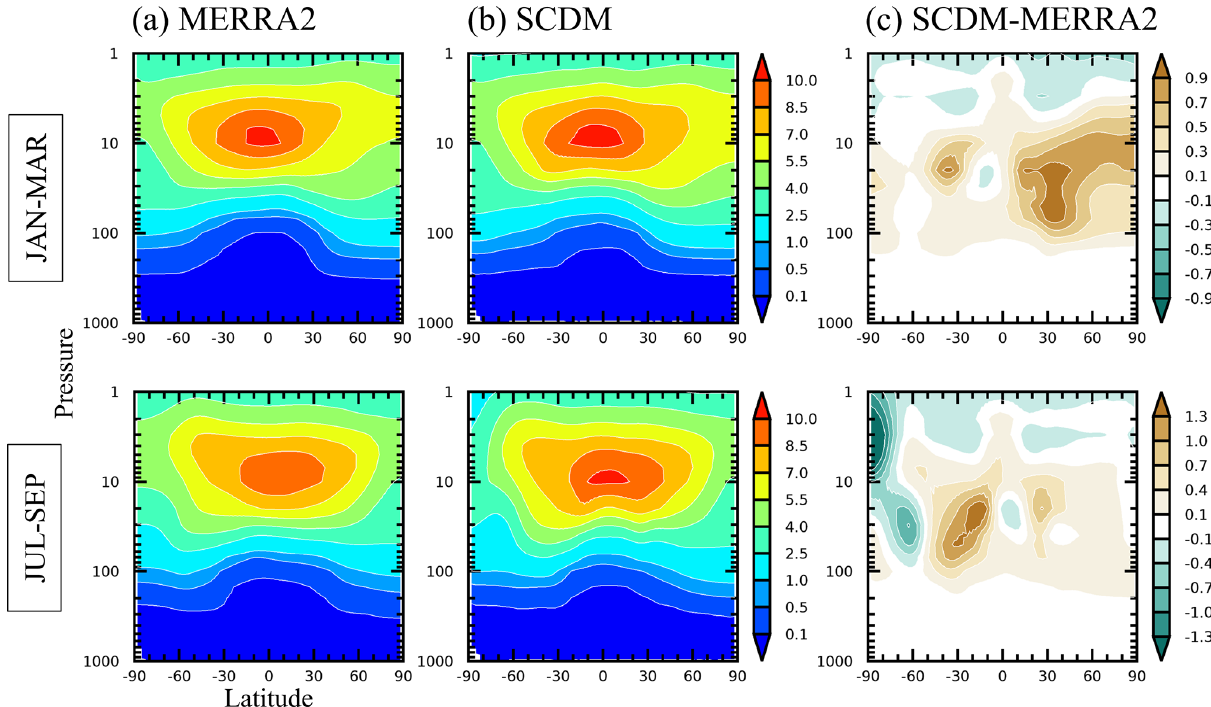
Figure 7. As Fig. 5 but for the zonal-mean volume ozone mixing ratio